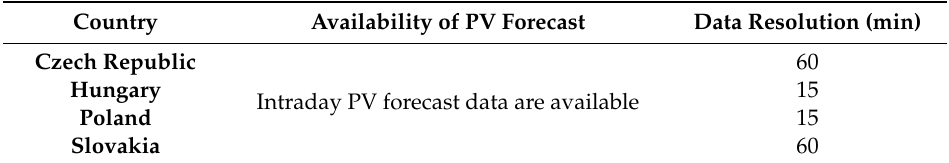
Table 1. Intraday photovoltaic (PV) forecast data in the Visegrad countries [83,84]. Country